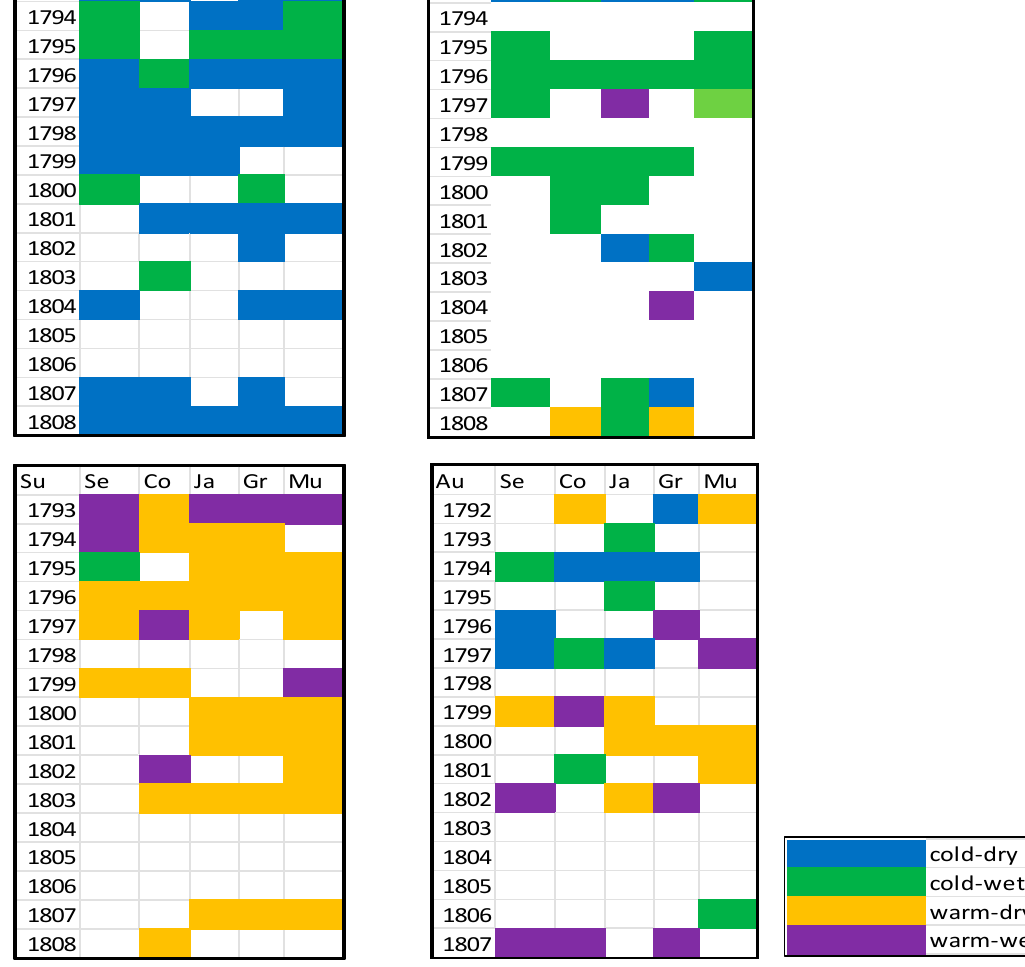
Figure 5. Combined temperature–rainfall character of the four seasons of the year (Wi = winter, Sp = spring, Su = summer, Au = autumn) and the five provinces studied (Se = Seville, Co = Córdoba, Ja = Jaén, Gr = Granada, Mu = Murcia).